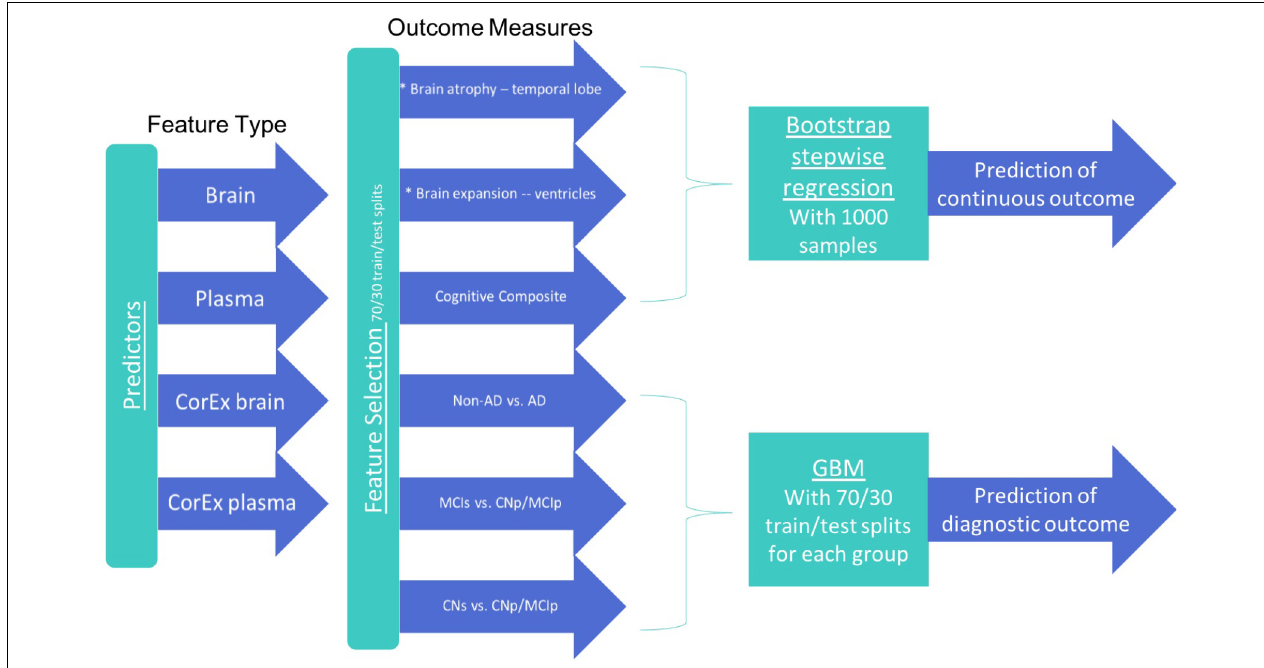
FIGURE 1 | Features and analytic methods included in the current analyses. After constructing latent factors using CorEx within plasma and brain measures separately, we performed feature selection for each feature type to determine the top 10 features for each outcome measure and each feature type. We combined these top features across feature types within each corresponding outcome and either (1) performed disease prediction with gradient boosting classification or (2) used bootstrap stepwise regression to determine the importance of the top features for predicting the continuous outcome measures (i.e., cognition and TBM atrophy